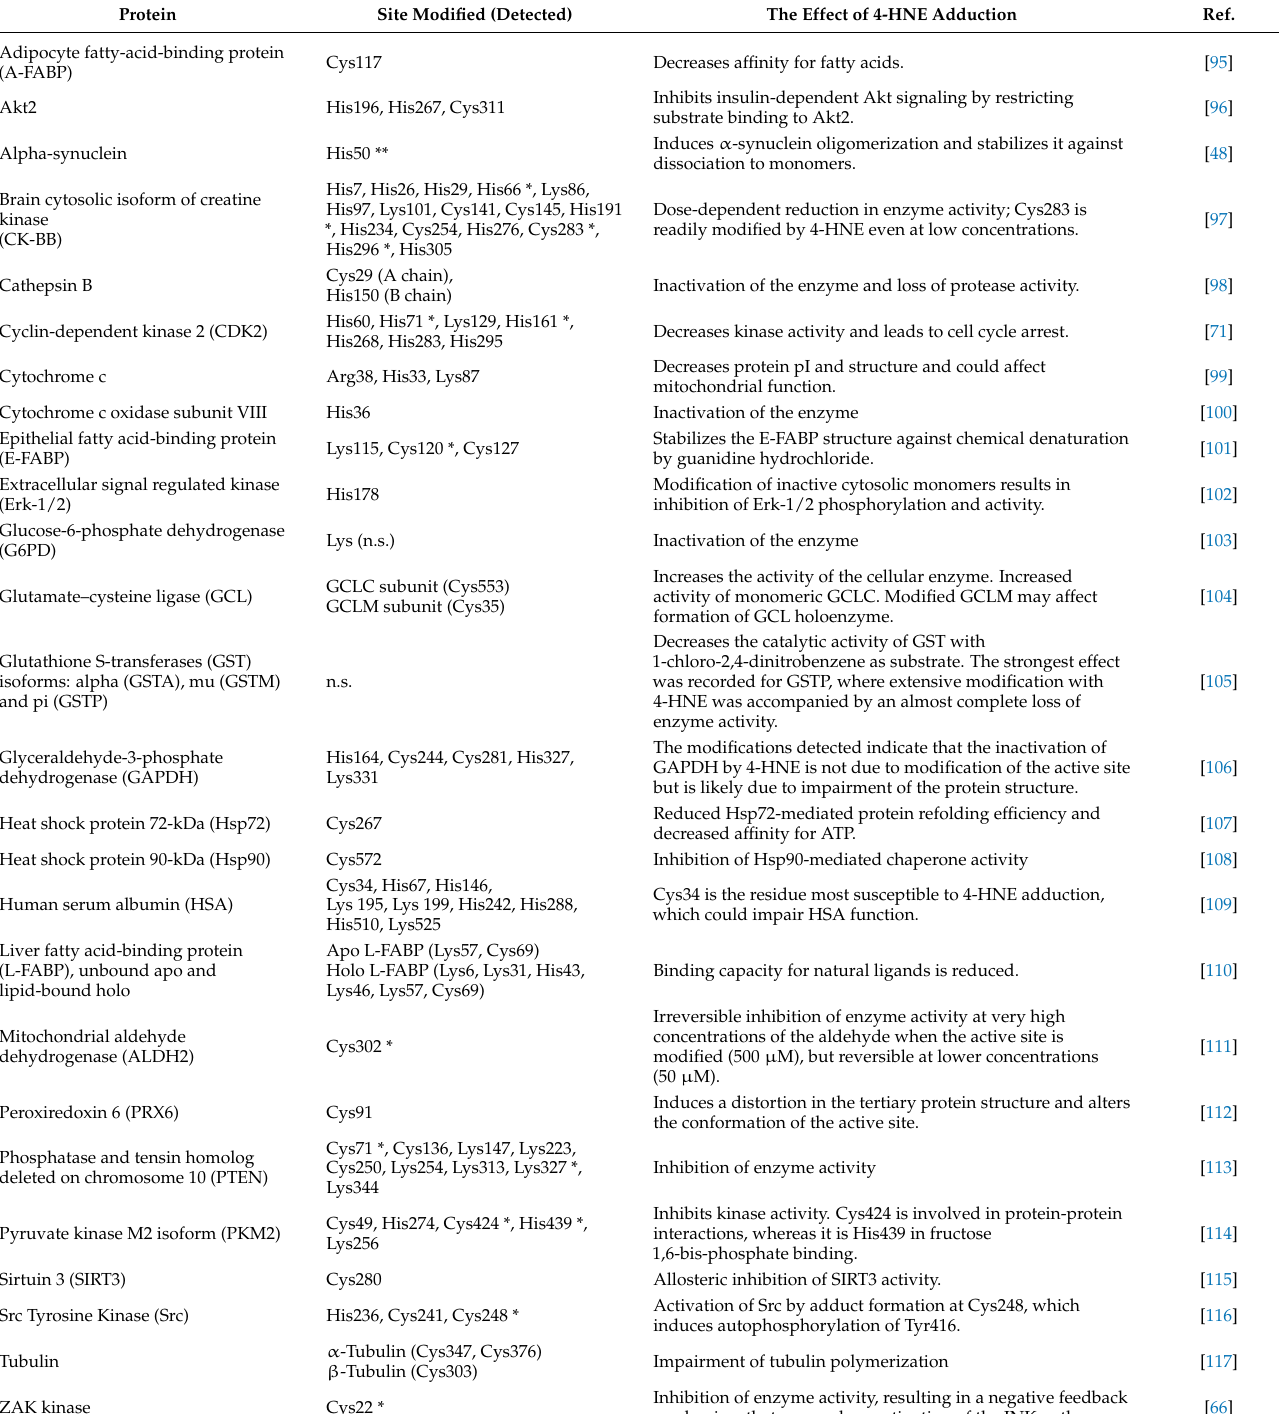
Table 3. Biological relevance of HNE-protein adducts detected by mass